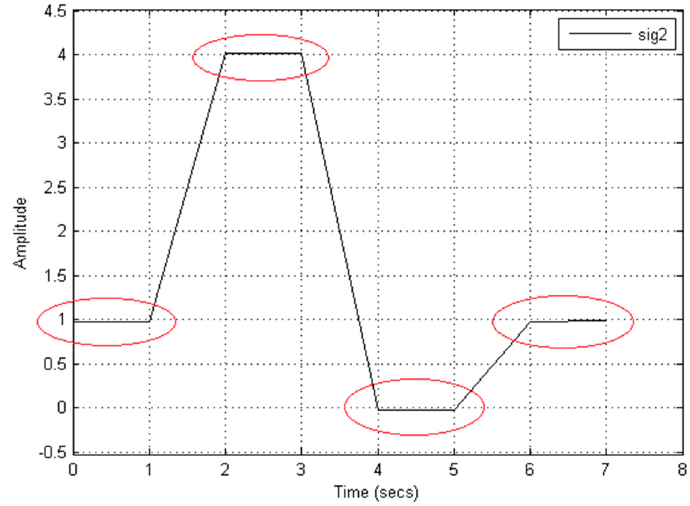
Figure 4. The recovered signal.